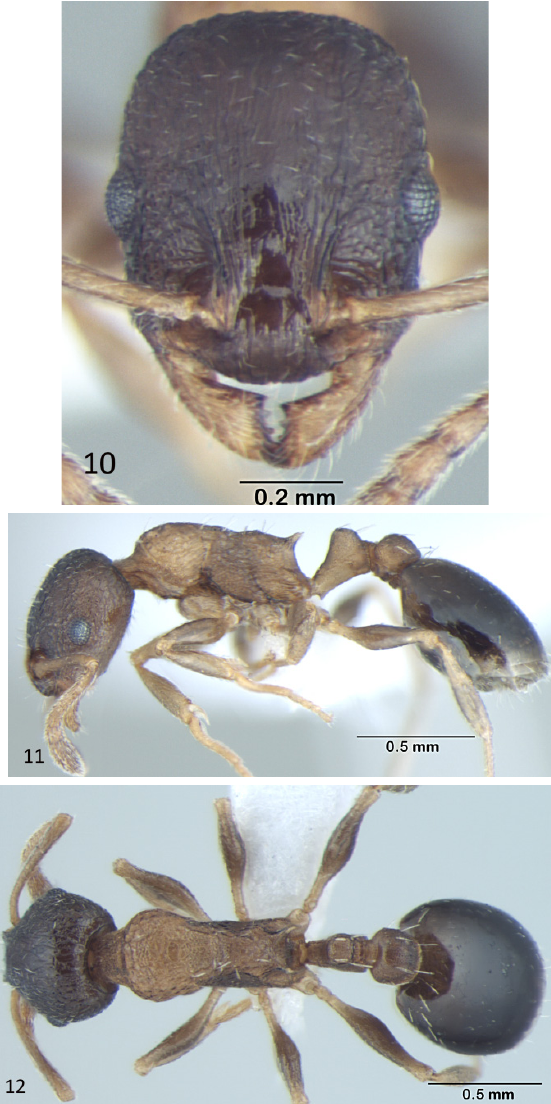
Figs 10-12. Worker Temnothorax rothneyi (Forel, 1902): 10-Head, full face view; 11- Body, lateral view; 12- Body, dorsal